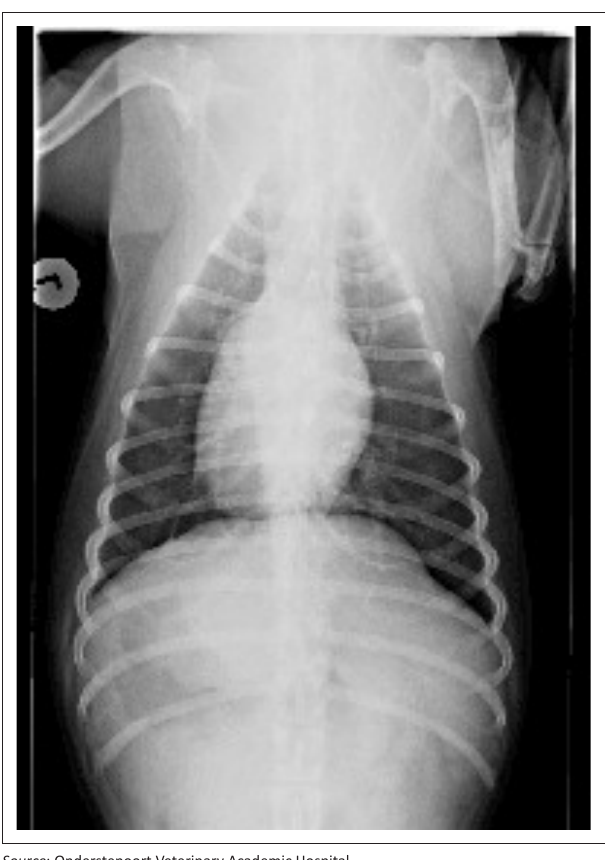
FIGURE 4: Ventro-dorsal thoracic radiograph – note that there are no signs of an undulating